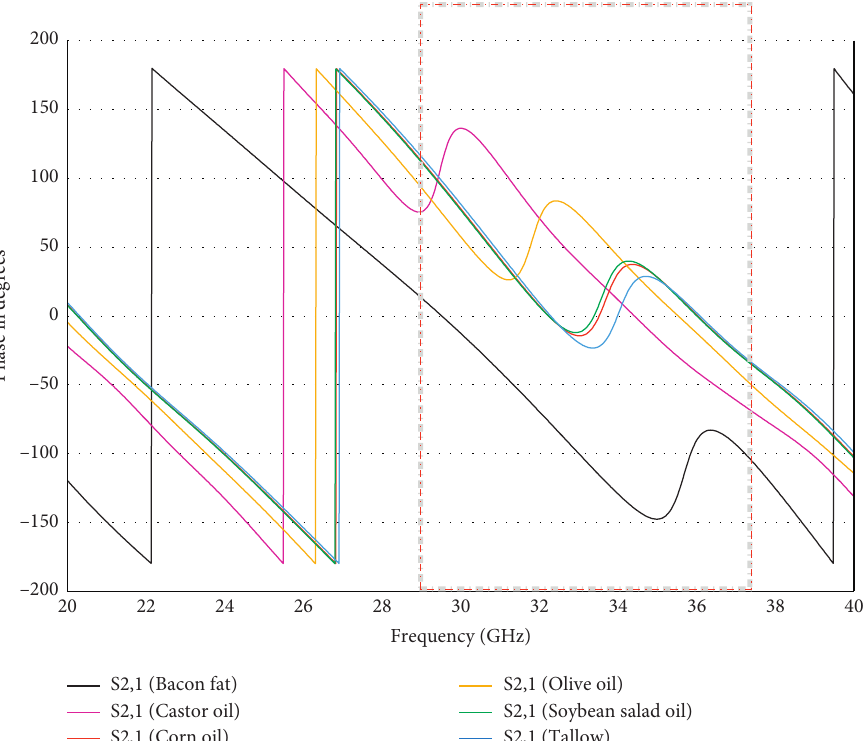
Figure 12: The shift in the transition of phase under MUT on different cooking oils at the resonance